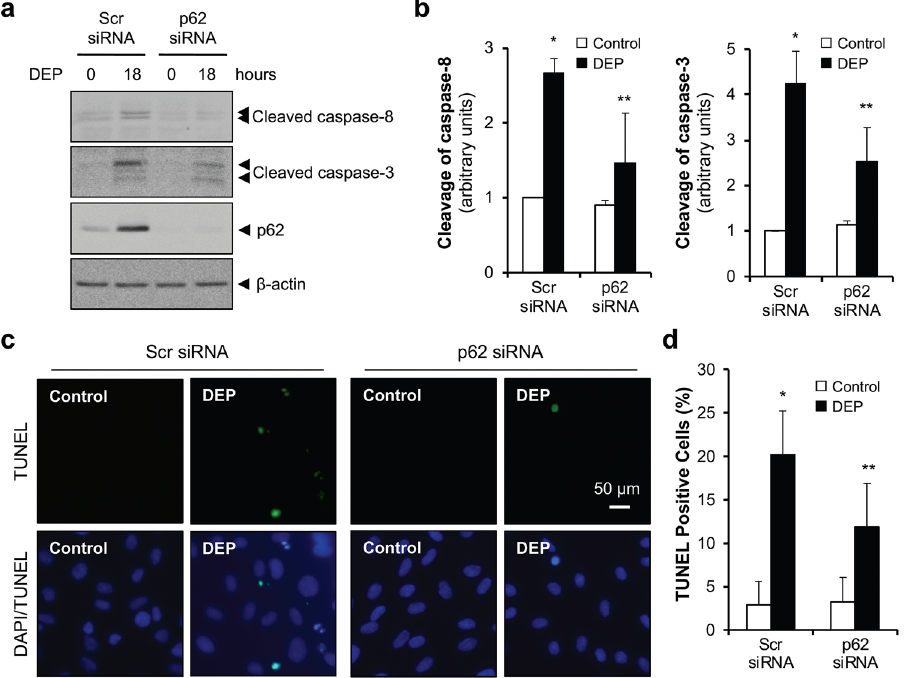
Figure 6. p62 depletion suppresses DEP-induced apoptosis. ( a ) HUVECs were transfected with scrambled or p62 siRNA and exposed to DEP (70 μg/ml) for 18 h. Cleavage of caspase-8 and caspase-3 were analyzed by immunoblotting. ( b ) Quantification of cleaved caspase-8 and cleaved caspase-3 normalized to β-actin. Results are presented as means ± SD ( n = 3). Statistical analysis was performed using one-way ANOVA. * P < 0.02 versus scrambled siRNA with control. ** P < 0.05 versus scrambled siRNA with DEP. ( c ) HUVECs were transfected with either scrambled or p62 siRNA and exposed to DEP (70 μg/ml). After 24 h, cells were subjected to TUNEL staining. ( d ) Quantification of TUNEL-positive cells. TUNEL-positive apoptotic cells were counted and expressed as a percentage of total nuclear counts. Results are presented as means ± SD from five randomly selected fields. Statistical analysis was performed one-way ANOVA. * P < 0.02 versus scrambled siRNA with control. ** P < 0.02 versus scrambled siRNA with DEP.